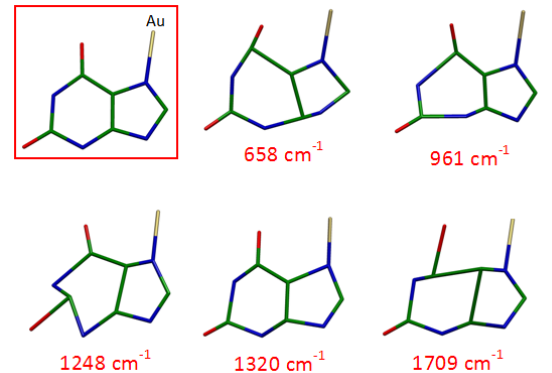
Figure 6. Normal modes of the N9(H)-Au + complex, corresponding to the prominent SERS bands of xanthine adsorbed on gold.